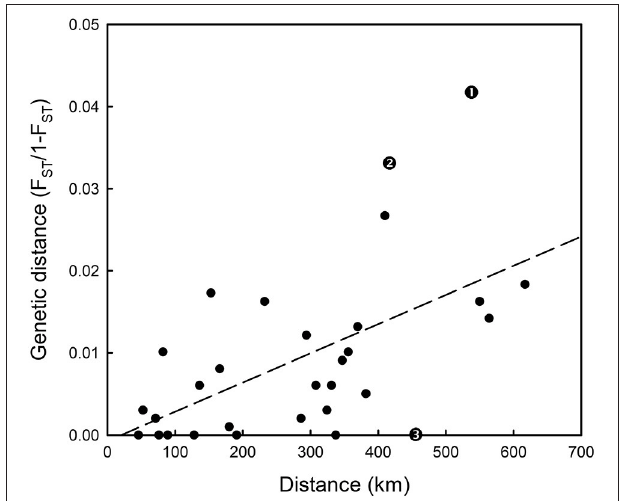
FIGURE 6 | Isolation by distance plot based on 2013–14 spawning and autumn Fst results in Table 6 and geographical separation between samples. Fitted linear regression line is also shown. Residuals with large leverage are indicated as follows: 1-Viking and ScIW spawning, 2-Viking and ScIW autumn, 3-ShIW and ScOW